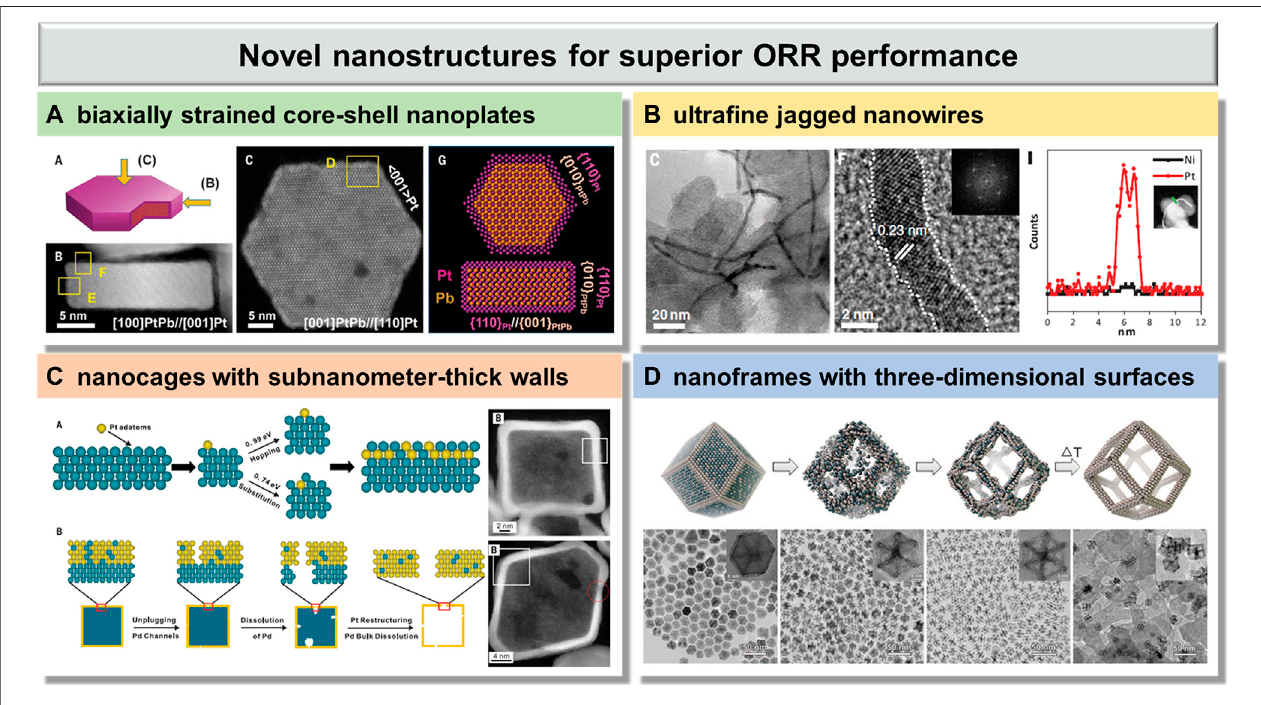
FIGURE1| EmergingPt-basedelectrocatalystswithnovelnanostructuresforsuperiorORRperformance: (A) biaxiallystrainedcore – shellnanoplates,reproduced with permission from ref. 20; (B) ultra fi ne jagged nanowires, reproduced with permission from ref. 18; (C) nanocages with subnanometer-thick walls, reproduced with permission from ref. 44; and (D) nanoframes with three-dimensional surfaces, reproduced with permission from ref. 48.